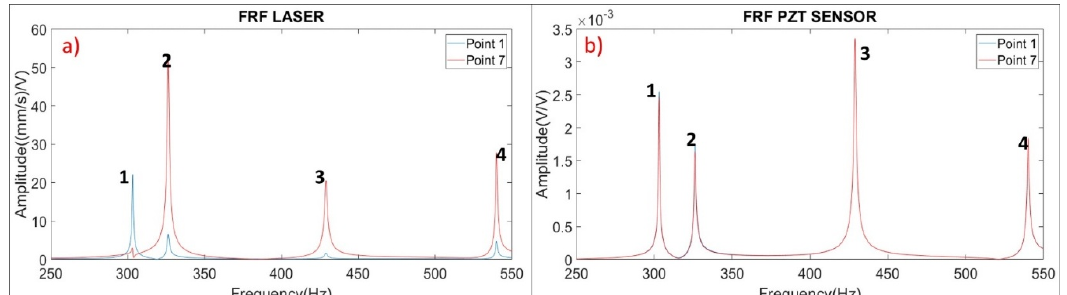
Figure 11. Analyzed diametrical modes. Experimental response of the structure measuring different positions of the bladed-disk with the LDV ( a ) and the PZT ( b ). Standing structure (not rotating).